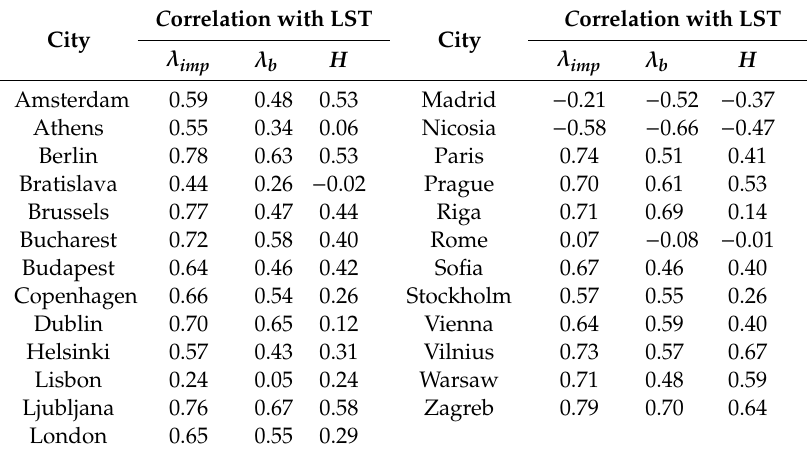
Table4. Spearman’s rho linearcorrelationbetweentheurbansurfaceparametersandLST(MODIS–Aqua) during daytime for all